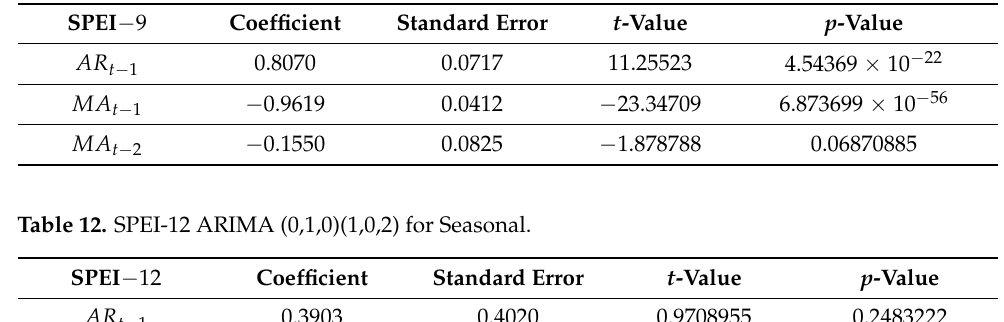
Table 11. SPEI-9 ARIMA (1,1,1)(1,0,0) for seasonal.